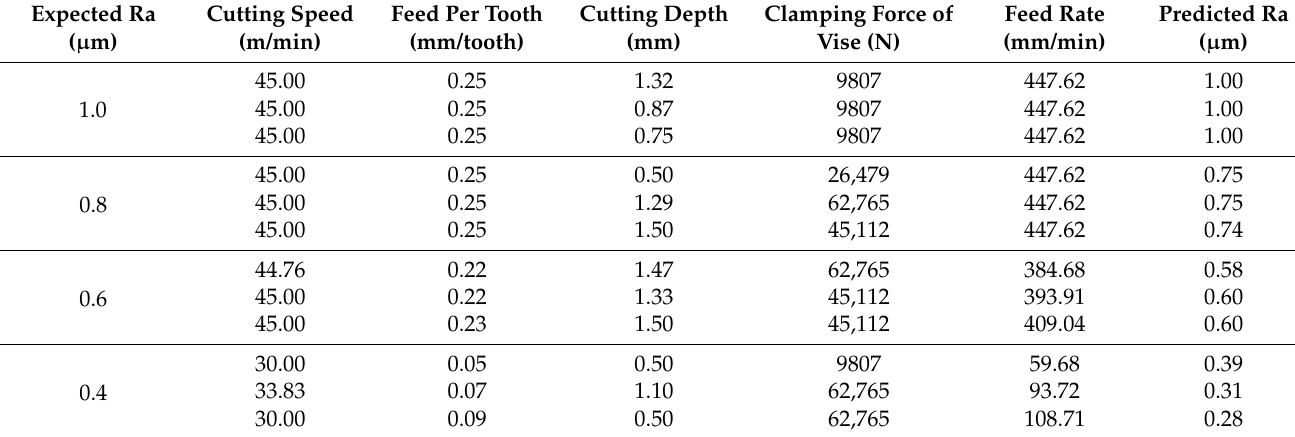
Table 7. Optimal cutting parameter combinations from particle swarm optimization (PSO) algorithm. Expected Ra